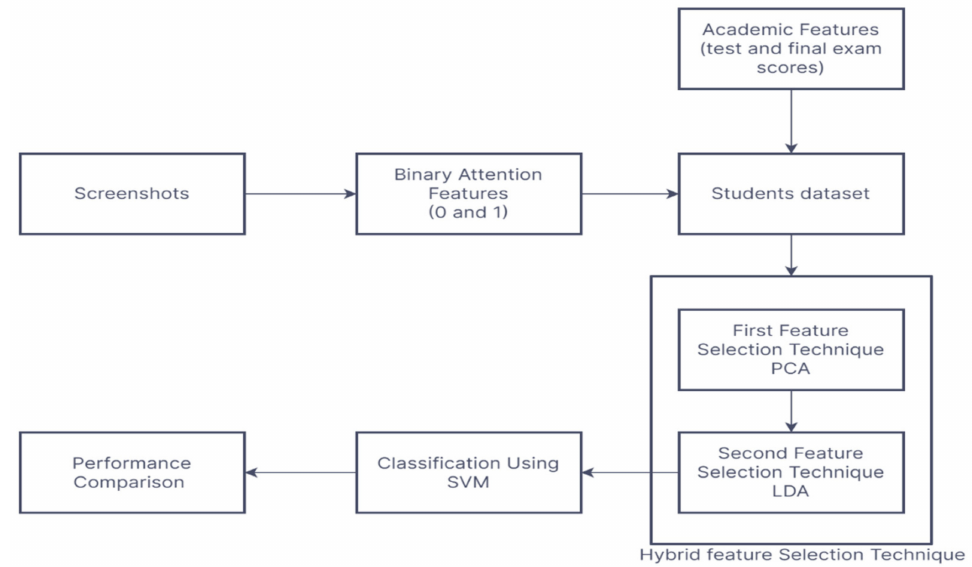
Figure 1. Proposed hybrid feature extraction